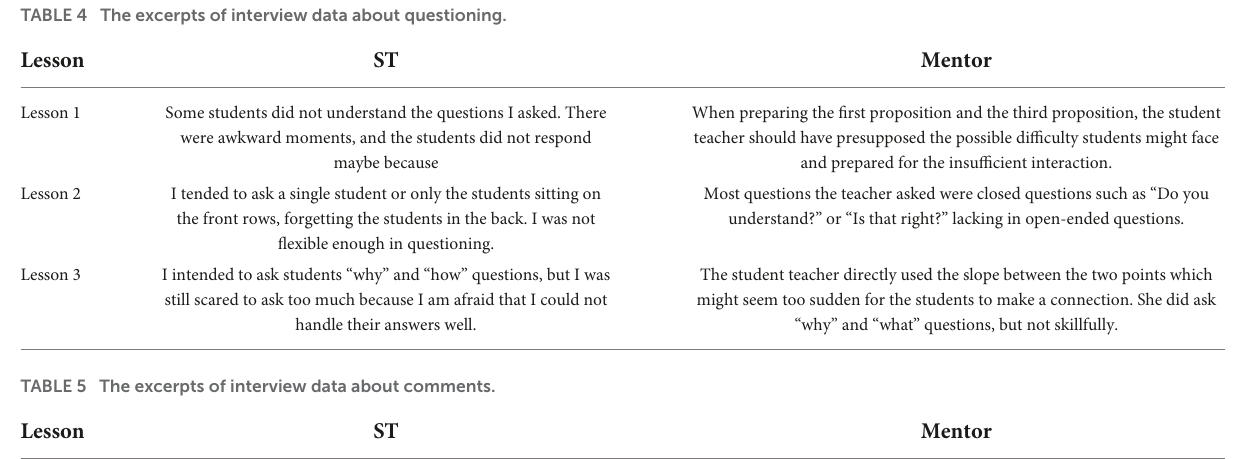
TABLE 4 The excerpts of interview data about questioning.